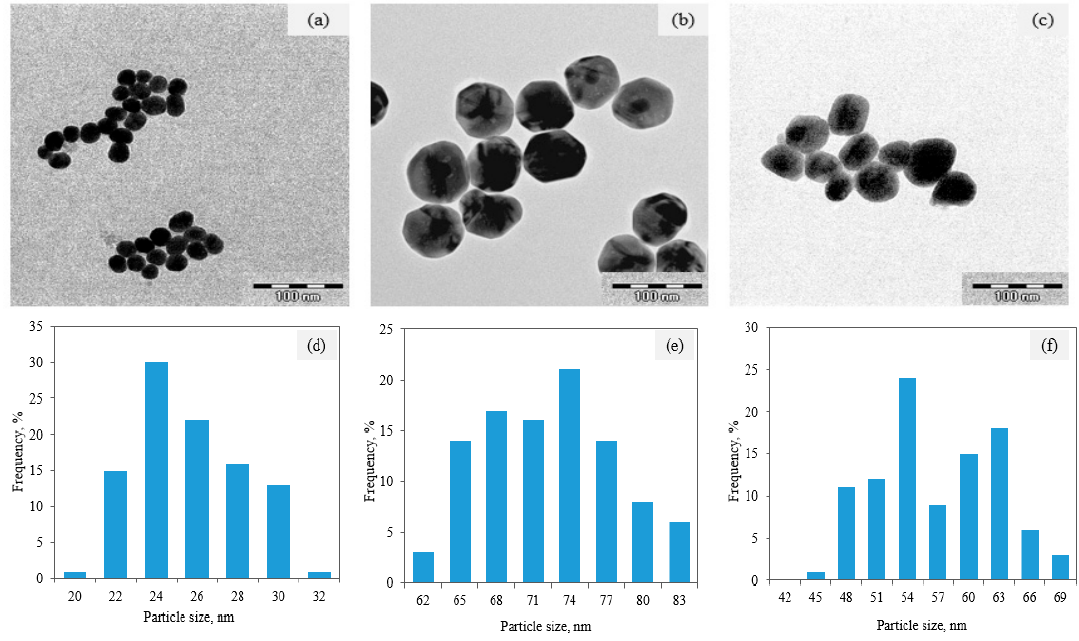
Figure 2. TEM images and corresponding particle size distribution of Au NPs ( a , d ), Au-Ag bimetallic NPs with 2.0 mL Au seeds ( b , e ), and Au-Ag NPs with 5.0 mL Au seeds ( c , f ).